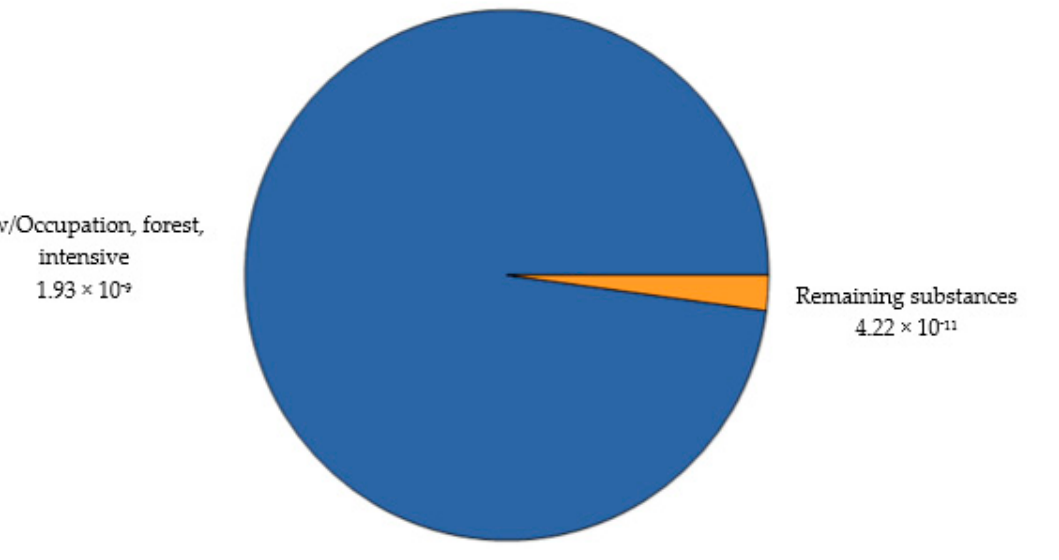
Figure 13. Agricultural land occupation impact assessment of 1 kg of SPF-reinforced sago starch composite takeout food container analyzed (damage assessment/excluding long-term emissions/cut off 1%).